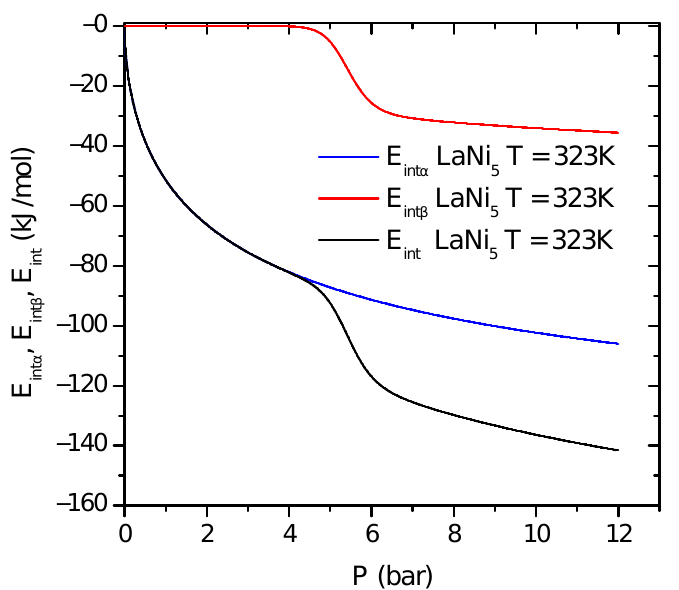
Figure 7. Evolution of the absorption internal energy of the first (Equation (21)) and second site (Equation (22)) and the overall energy versus pressure for T = 323 K presented only for LaNi 5 (Equation (20)). The similar energy evolution is observed for LaNi 4.75 Pb 0.25